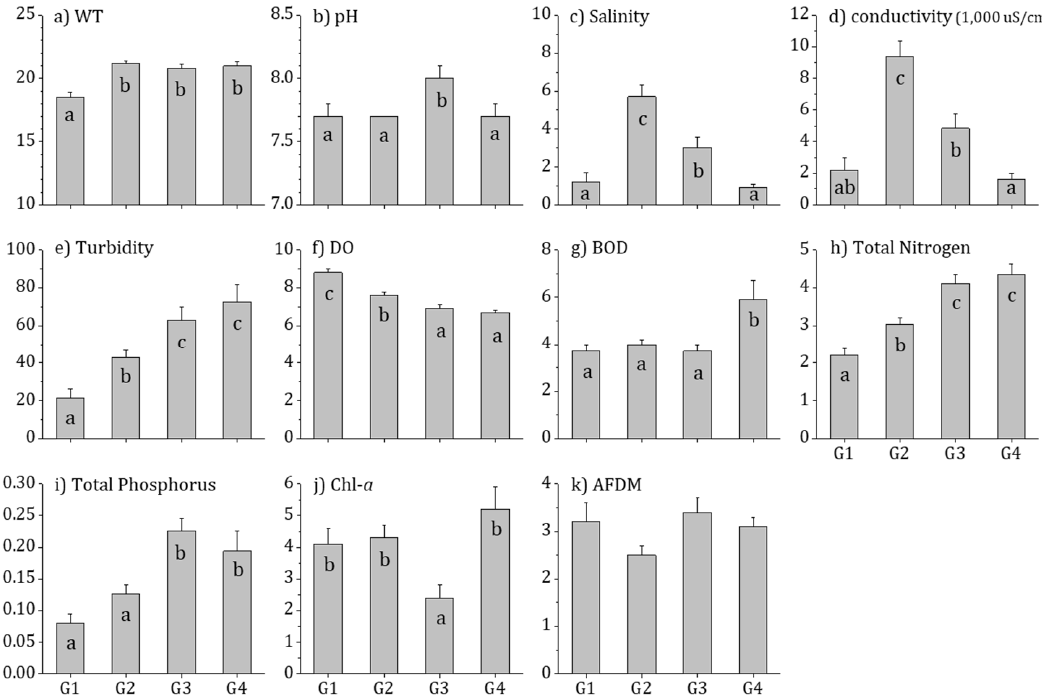
Figure 5. Environmental variables in four groups of Korean estuaries between 2009 and 2016. Small letters (a–c) indicate Tukey’s post hoc test with the Bonferroni test: ( a ) WT, Water temperature (°C); ( b ) pH; ( c ) Salinity (ppt); ( d ) conductivity, electric conductivity (1000 µ S / cm); ( e ) Turbidity; ( f ) DO, Dissolve oxygen (mg / L); ( g ) BOD, Biochemical oxygen demand (mg / L); ( h ) Total Nitrogen (mg / L); ( i ) Total Phosphorus (mg / L); ( j ) Chl- a , Chlorophyll- a (mg / cm 2 ); and ( k ) AFDM, Ash-free dry-matter (mg / cm 2 ).